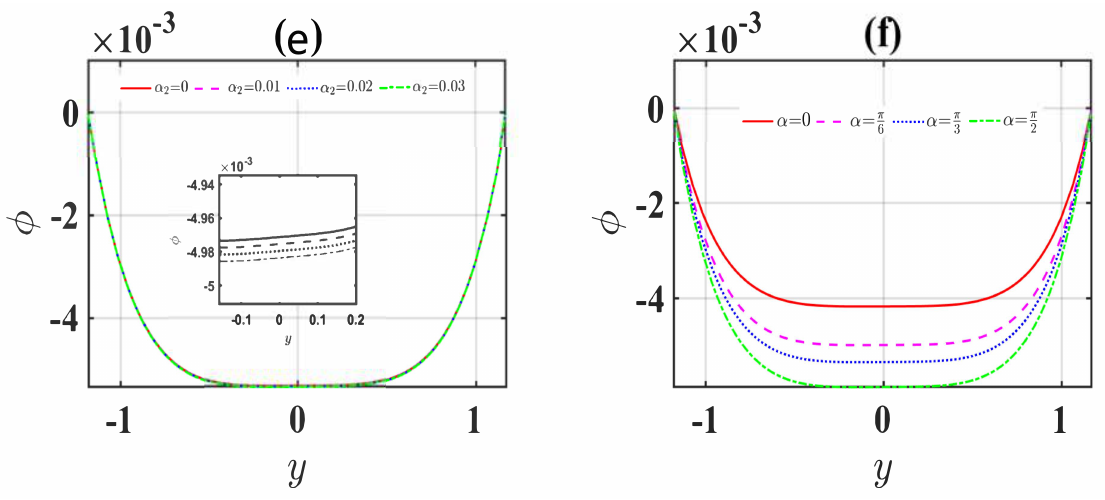
Figure 5. Concentration profiles for varying ( a ) U hs , ( b ) m e , ( c ) λ 1 , ( d ) α 2 , ( e ) α 1 , and ( f ) α .